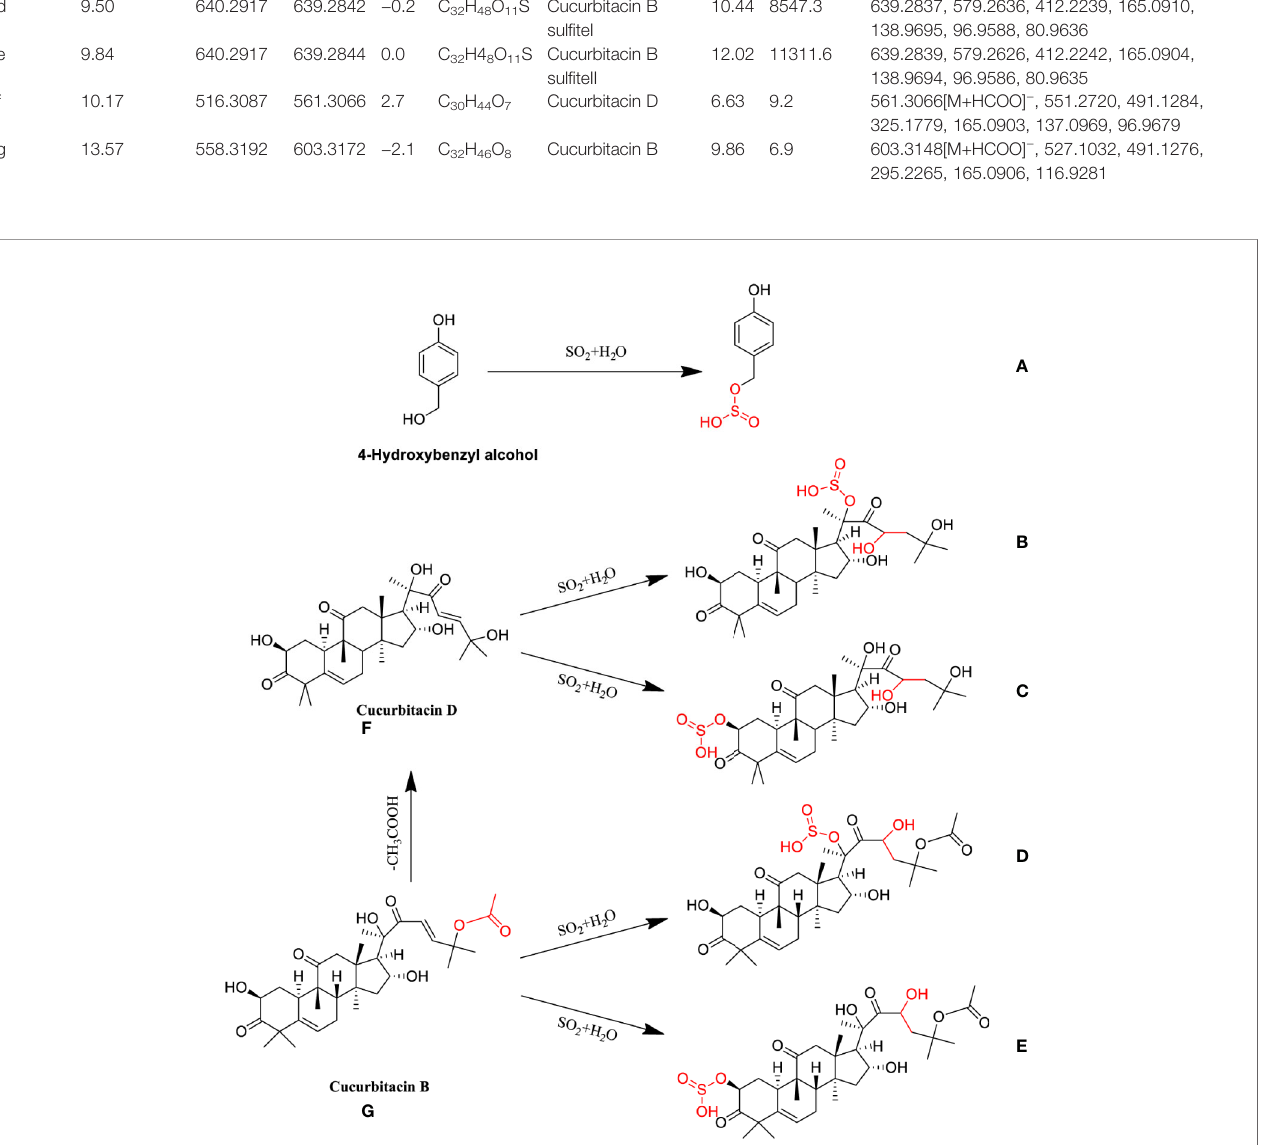
FIGURE 4 | Possible chemical structure changes of the markers in TR during sulfur fumigation. (A) p-Hydroxybenzyl hydrogen sul fi te; (B) Cucurbitacin D sul fi te I; (C) Cucurbitacin D sul fi te II; (D) Cucurbitacin B sul fi te I; (E) Cucurbitacin B sul fi te II; (F) Cucurbitacin D, (G) : Cucurbitacin